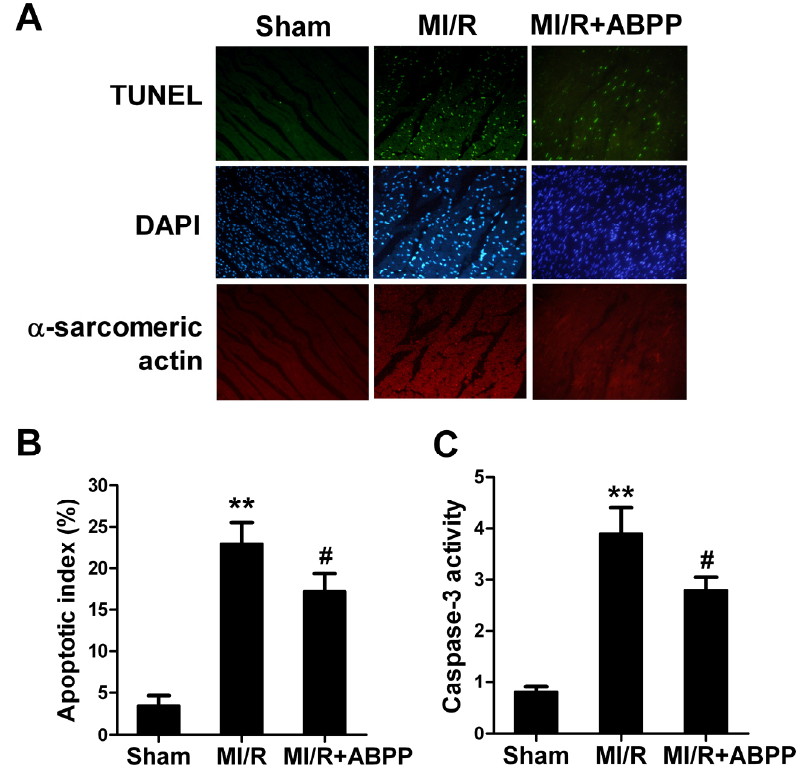
Figure 3. Achyranthes bidentata polypeptides (ABPP) preconditioning reduced myocardial apoptotic index and caspase-3 activity in rats subjected to myocardial ischemia/reperfusion. ( A ) Top: representative photomicrographs of in situ detection of apoptotic myocytes by terminal deoxynucleotidyl nickend labeling (TUNEL) staining in ischemic heart tissue from rats subjected to 30 min of ischemia and 4 h of reperfusion. Green fluorescence shows TUNEL-positive nuclei; Blue fluorescence shows nuclei of total cardiomyocytes. Bottom: percentage of TUNEL-positive nuclei in heart tissue sections; ( B ) Myocardial caspase-3 activity. MI/R, myocardial ischaemia/reperfusion (30 min/4 h); Sham, sham-operated; ABPP, Achyranthes bidentata polypeptides. Values presented